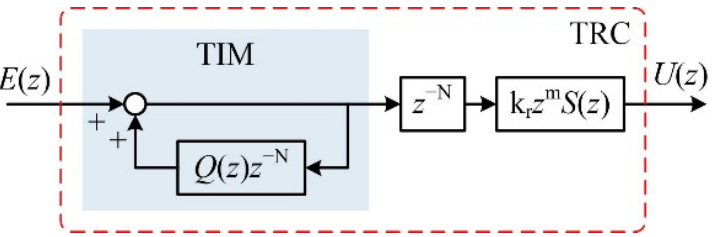
Figure 2. Schematic diagram of the TRC.